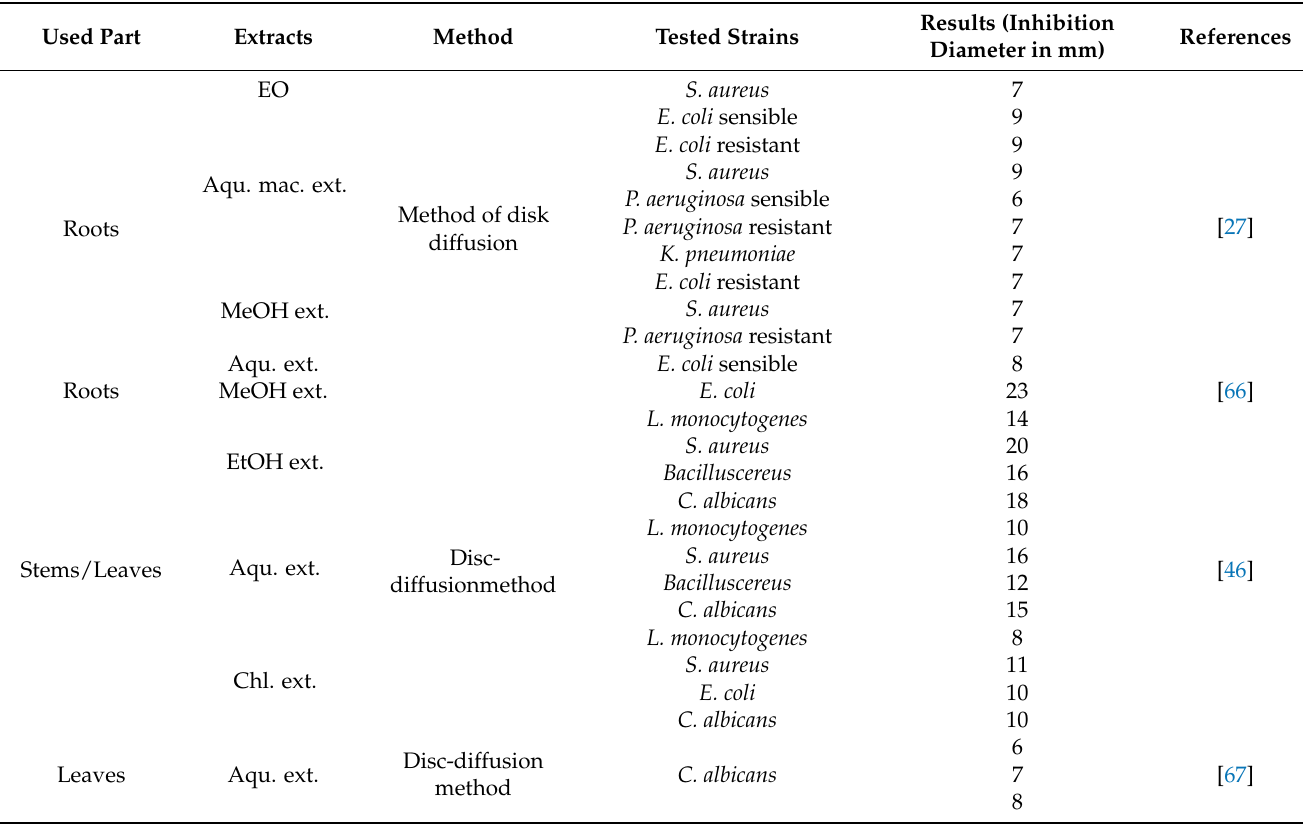
Table 3. Antimicrobial activity of Anacyclus pyrethrum